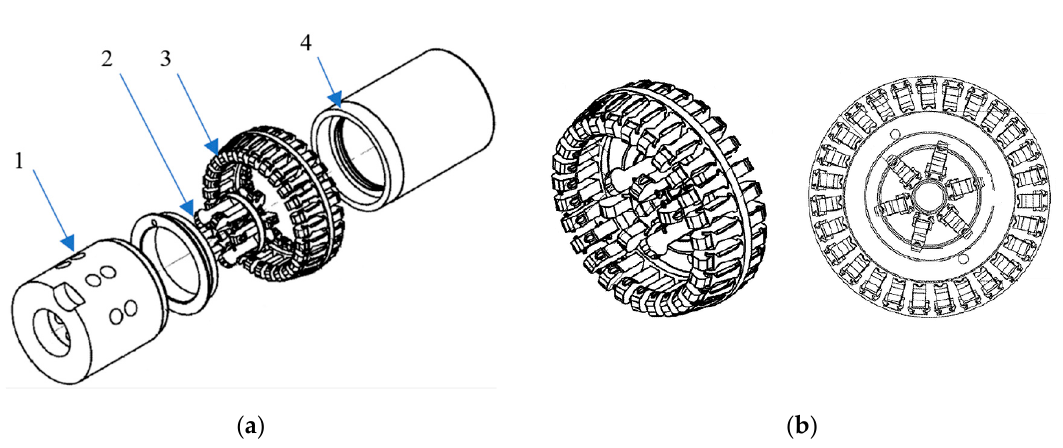
Figure 2. Structural view of the tulip contact: ( a ) 1—movable part of the contact, 2—inner crown lamellas, 3—outer crown lamellas, and 4—lamella seating, and ( b ) detailed view of tulip contact lamellas [24].